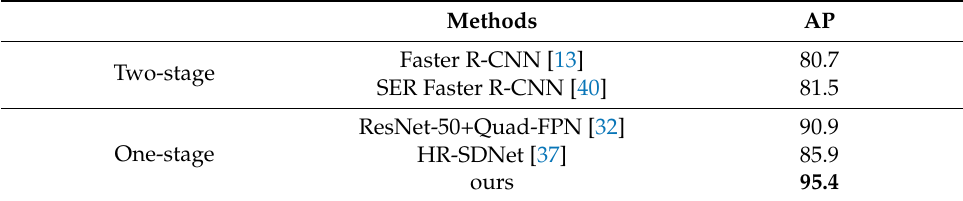
Table 5. Comparison with the latest SAR ship detection methods on